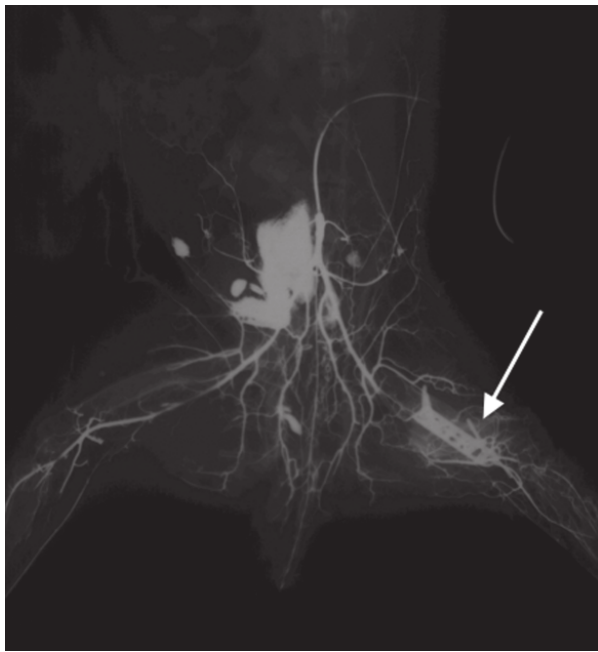
Figure 3 - Arteriographic images of the vascular system of lower abdomen and lower extremities obtained during forced hyperabduction illustrates the location of the osteotomy as well as the longitudinal orientation of the metallic plate and screws in the proximal femoral diaphysis of an adult rabbit 6 weeks after an intertrochanteric osteotomy which was used for stabilization. Intense vascularity is noted at the healing site (arrow) with contrast opacification of both common iliac arteries, both superficial and profunda femoral arteries, and their